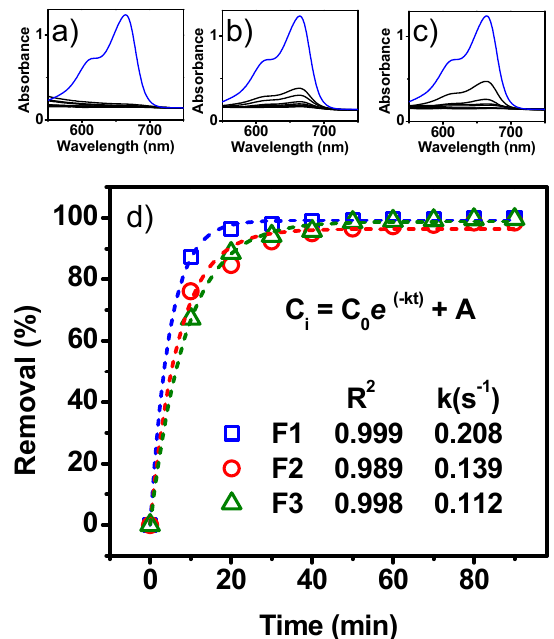
Figure 9. Evaluation of varying the water flow in methylene blue removal: ( a , b , c ) UV-Vis spectra for 3 (F1), 5 (F2) and 9 mL/s (F3), respectively. ( d ) Removal curves for each condition.